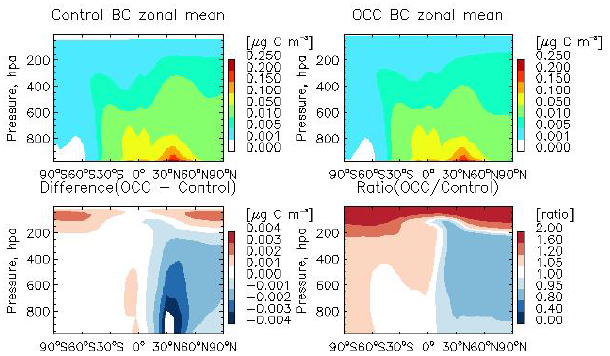
Fig. 6a. Model simulated annual mean surface BC concentrations from the sensitivity run versus the control run. (Upper left) BC con- centrations from the control run; (upper right) BC concentrations from the sensitivity run using the combined aging scheme; (lower left) differences between the sensitivity run and control run results; (lower right) ratio between sensitivity run and control run results. OCC (hereinafter) represents the combined aging scheme.